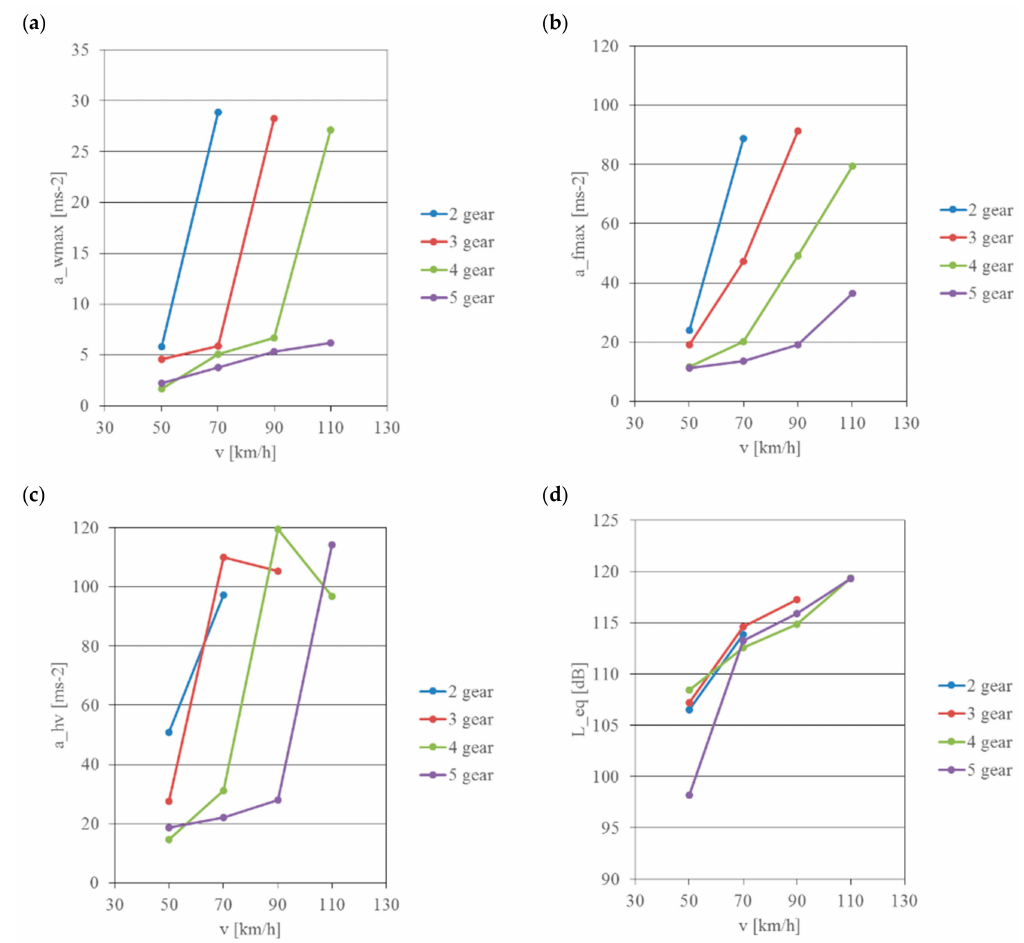
Figure 8. Change of noise and vibration acceleration depending on the travelling speed and the selected gear—signals not frequency corrected: ( a ) measuring point—seat, ( b ) measuring point—footrest, ( c ) measuring point—handlebars, ( d ) measuring